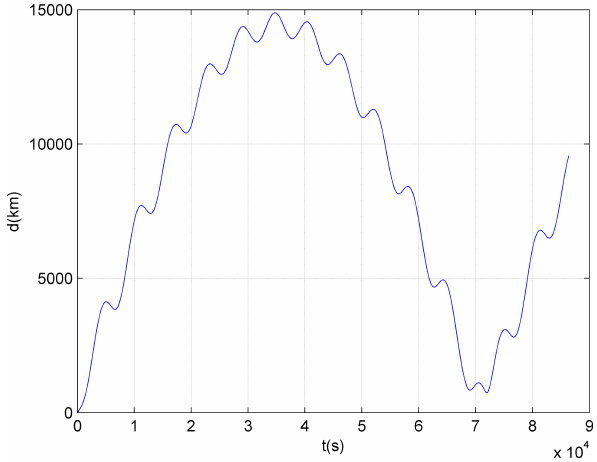
Figure 4. The relative distance between objects A and B.